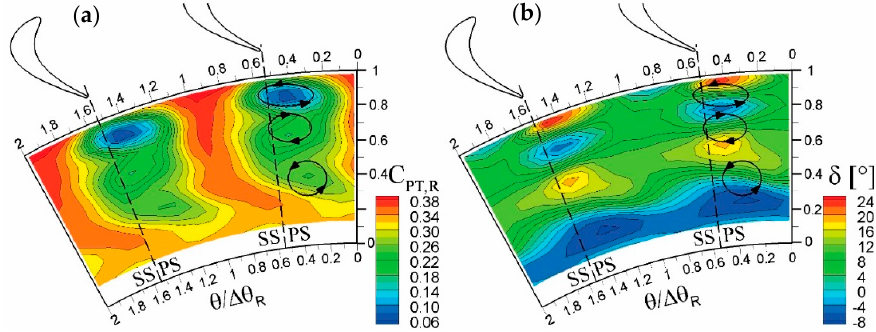
Figure 9. Rotor-exit relative flow field in OP3, ( a ) relative total pressure coefficient; ( b ) deviation angle.